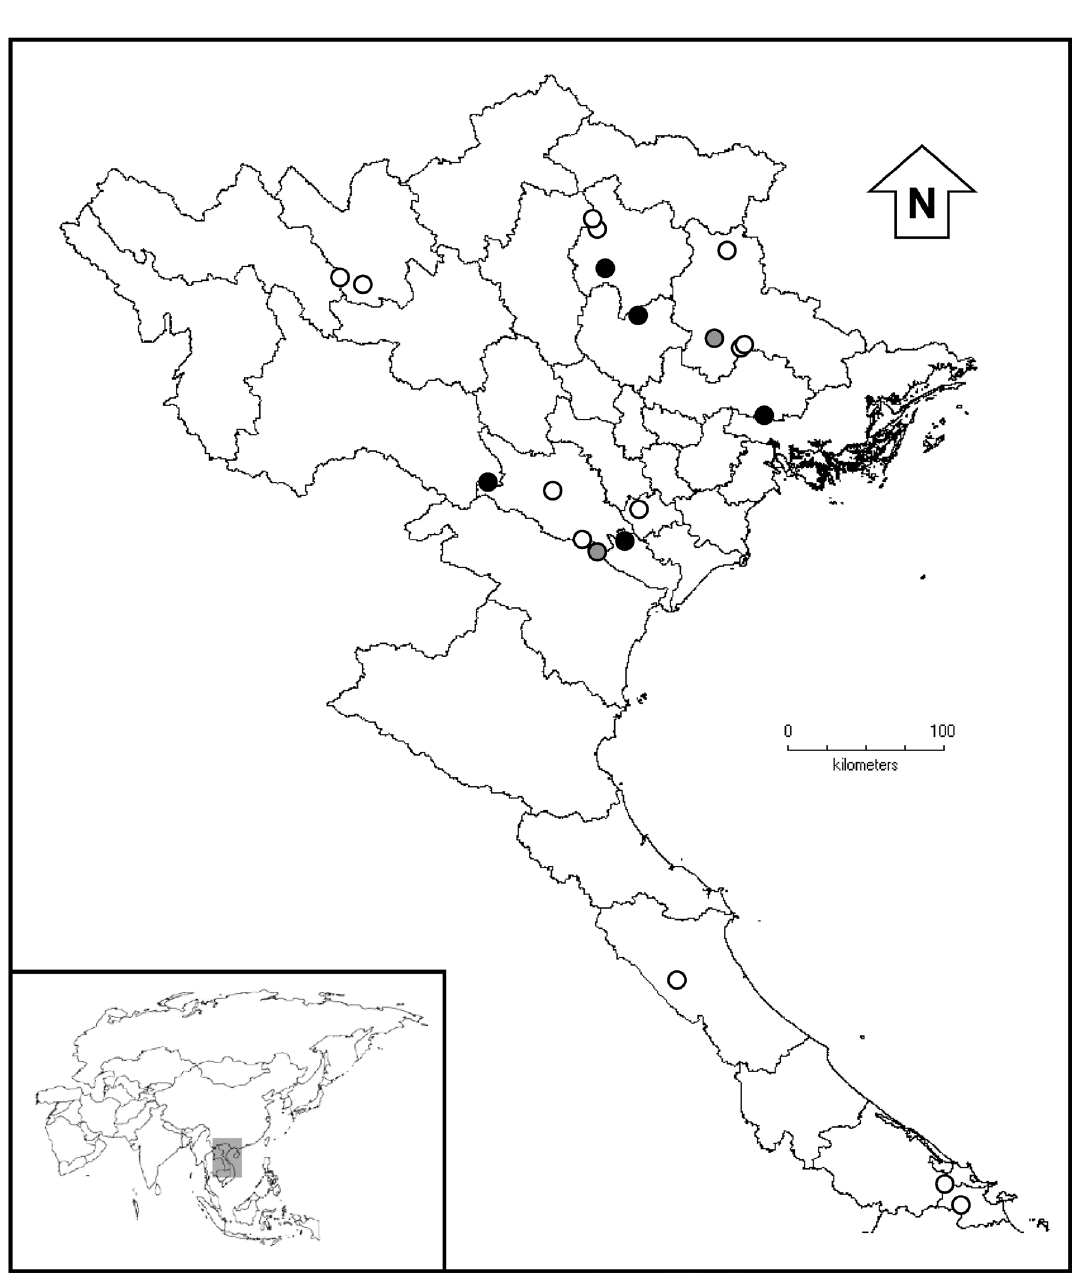
Figure 5. Revised distribution map for North Vietnamese Pollicaria species. Pollicaria rochebruni is present at all sites shown. Black dots indicate the presence of P. mouhoti , while gray dots indicate the presence of the putative new species of Kongim et al. (2013). Coordinates for localities taken from museum data were estimated from historical